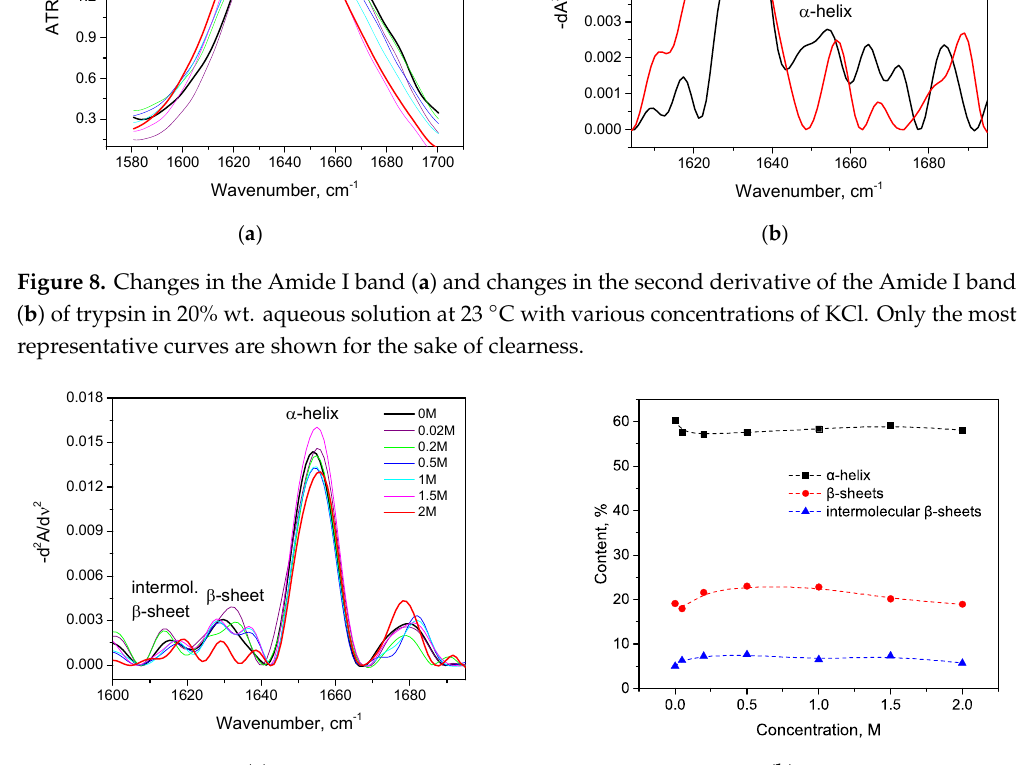
Figure 8. Changes in the Amide I band ( a ) and changes in the second derivative of the Amide I band ( b ) of trypsin in 20% wt. aqueous solution at 23 °C with various concentrations of KCl. Only the most representative curves are shown for the sake of clearness.